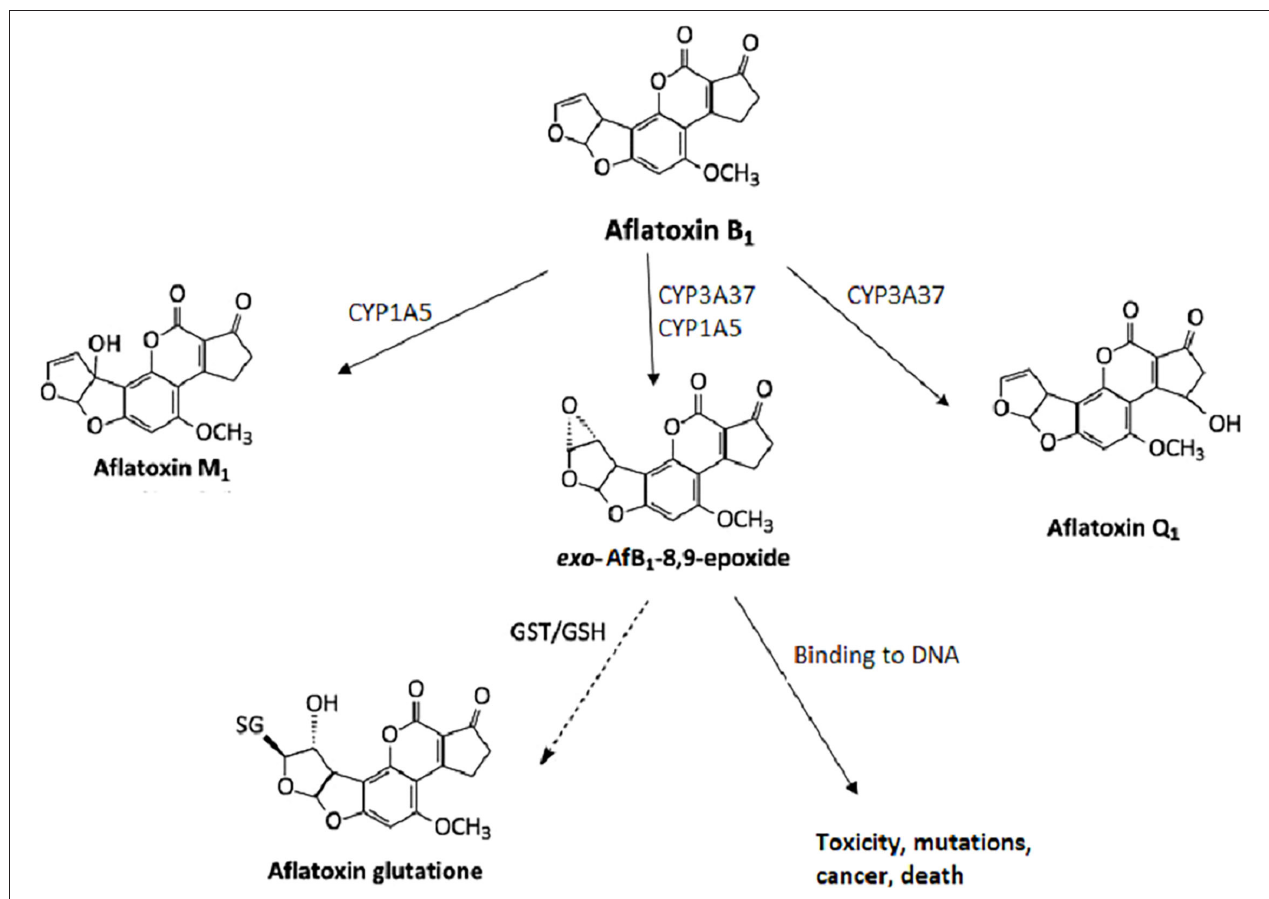
FIGURE 2 | Metabolism of aflatoxin B1 in